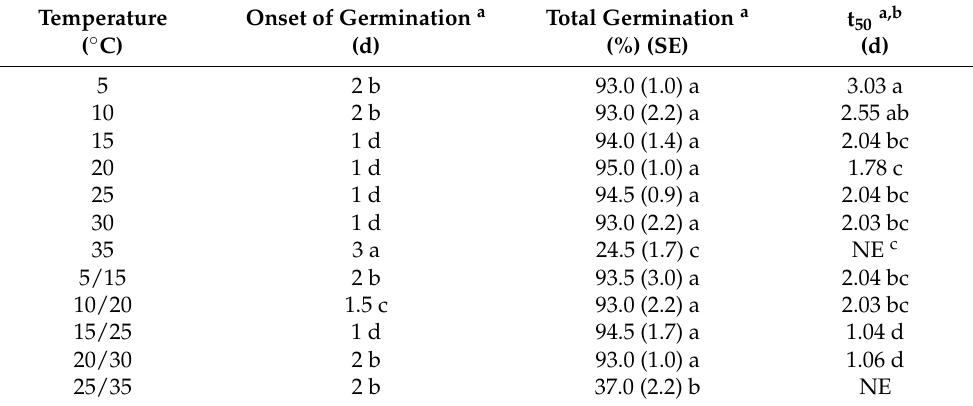
Table 1. Germination percentages and days required to reach 90% germinations (t 90 ) for Vicia villosa seeds exposed to different constant and alternating temperatures under a 12/12-h dark/light pho- toperiod for 21